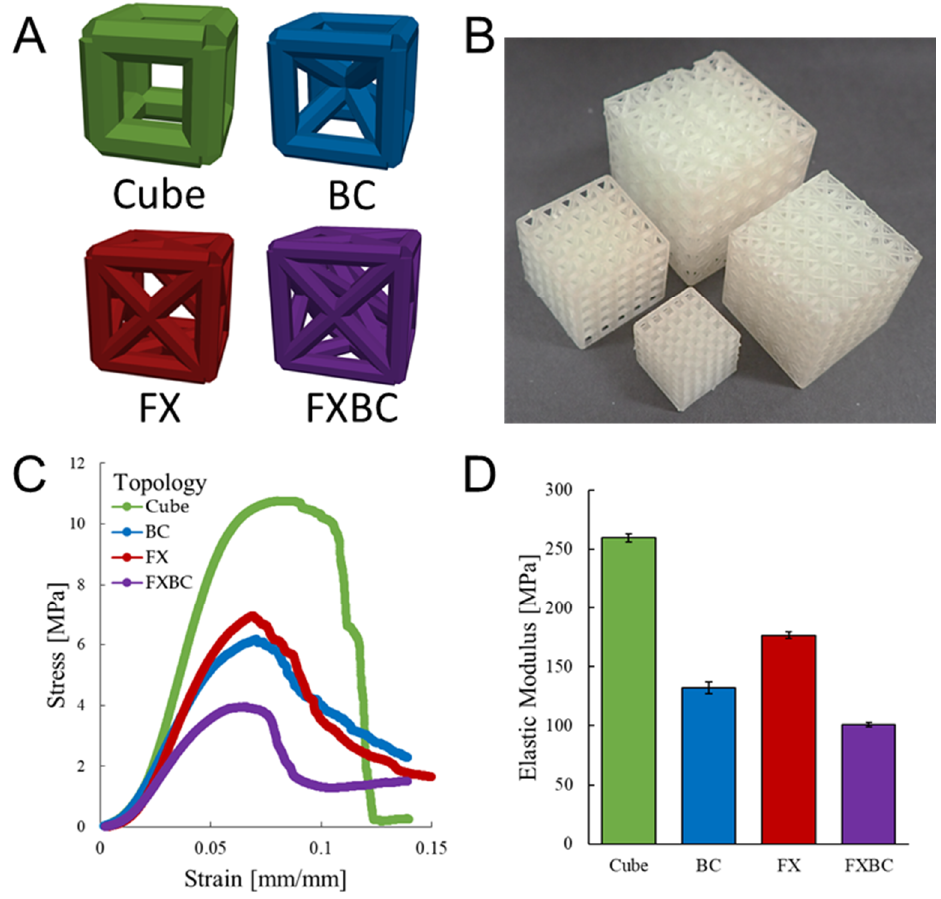
Figure 3. Topologies including ( A ) Cube, body-centered (BC), face-crossed (FX), and face-crossed body-centered (FXBC) unit cells with resulting ( B ) fabrications, ( C ) stress-strain curves, and ( D ) elastic moduli